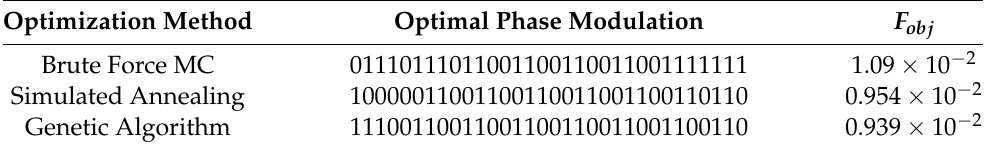
Table 1. Comparison of various phase-only optimization methods for the target intensity profile in Figure 6a.